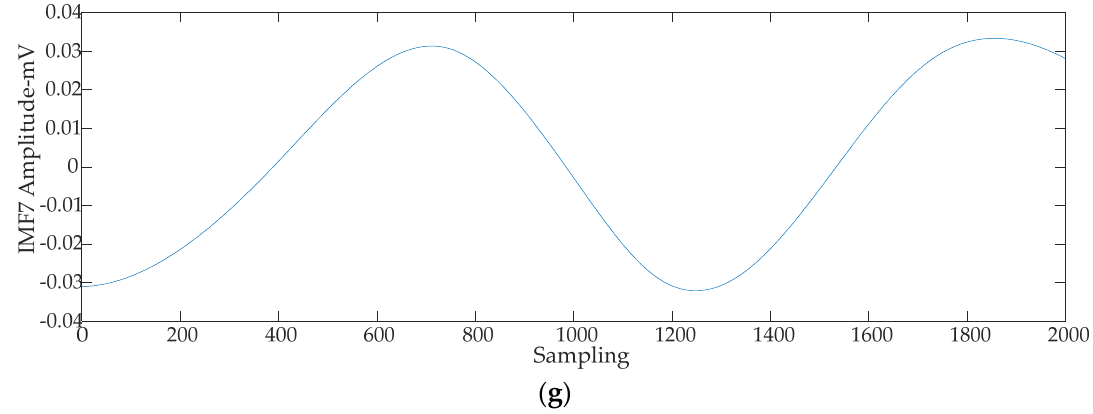
Figure 10. Empirical mode decomposition (EMD) PD superimposed narrowband interference signal. ( a ) IMF 1 -component. ( b ) IMF 2 -component. ( c ) IMF 3 -component. ( d ) IMF 4 -component. ( e ) IMF 5 -component. ( f ) IMF 6 -component. ( g ) IMF 7 -component.